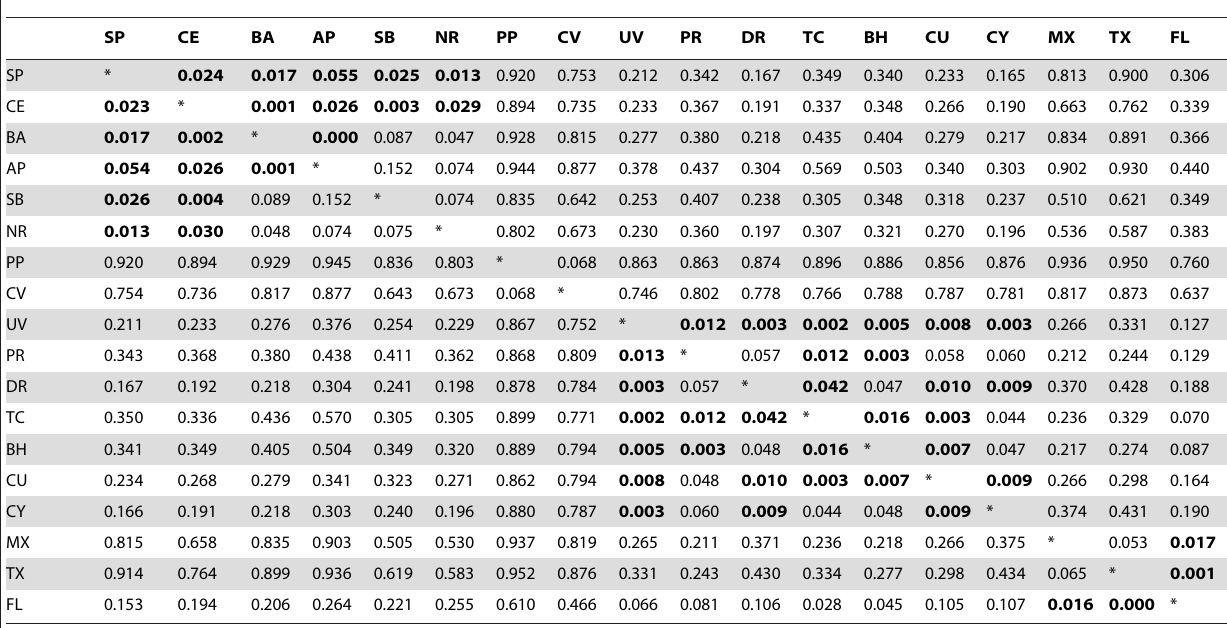
Bold indicates lack of significant difference (p . 0.05). SP= Sa˜o Pedro and Sa˜o Paulo, CE= Ceara´ coast, BA= Bahia coast, AP= Abrolhos Park, SB= South Brazil, NR= Noronha/Rocas, PP= Principe, CV= Cape Verde, UV= U.S. Virgin Islands, PR= Puerto Rico, DR= Dominican Republic, TC= Turks & Caicos, BH= Bahamas, FL= Florida, CY= Cayman Islands, MX= Mexico, TX= Texas, FL= Florida.